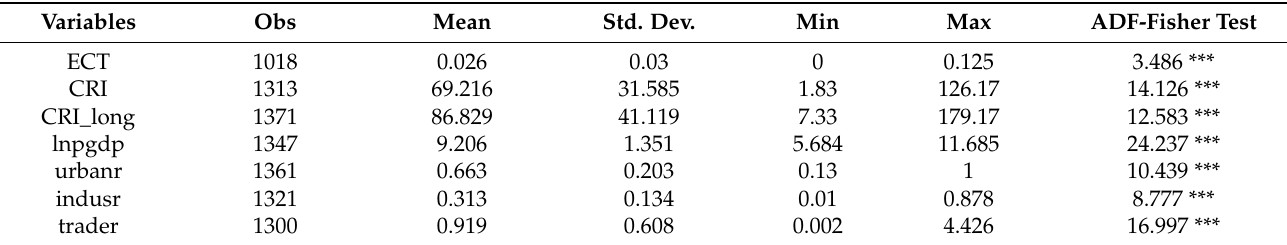
Table 2. Descriptive Statistics.